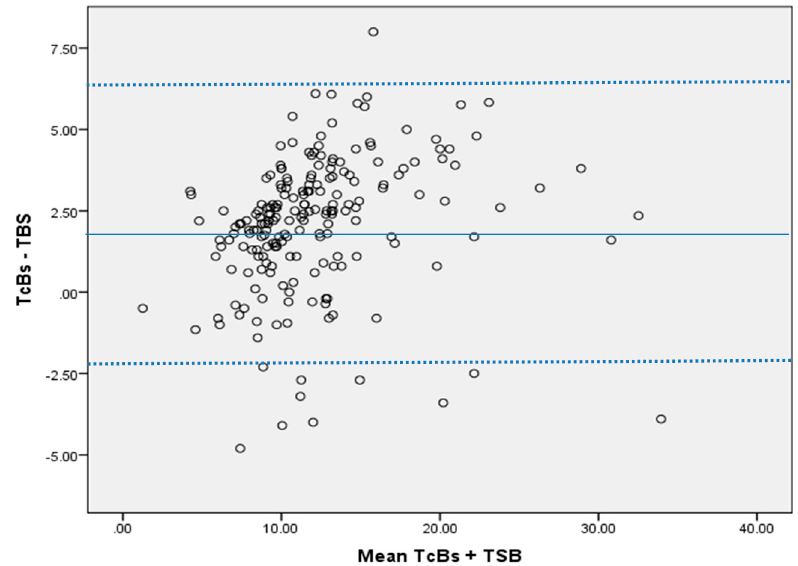
Figure 2. Bland-Altman plot showing mean difference and limits of agreement of measurements of TSB and TcBS.